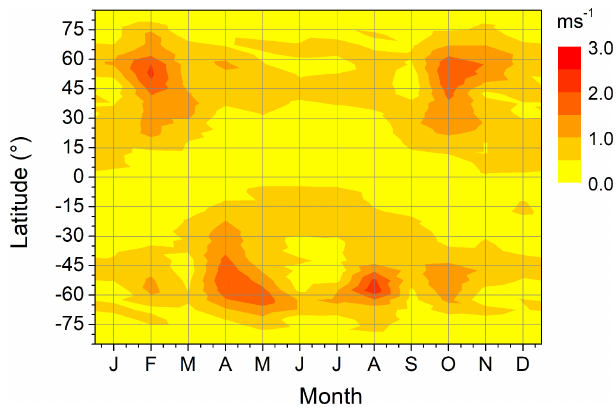
Figure 4. QDT zonal wind amplitudes at 100 . 9km altitude, as mod- eled by